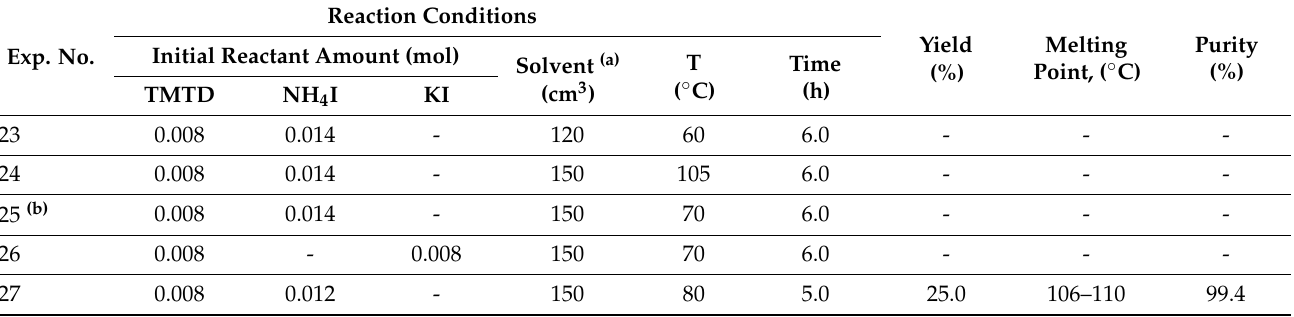
Table 5. Results of TMTS synthesis using the iodide